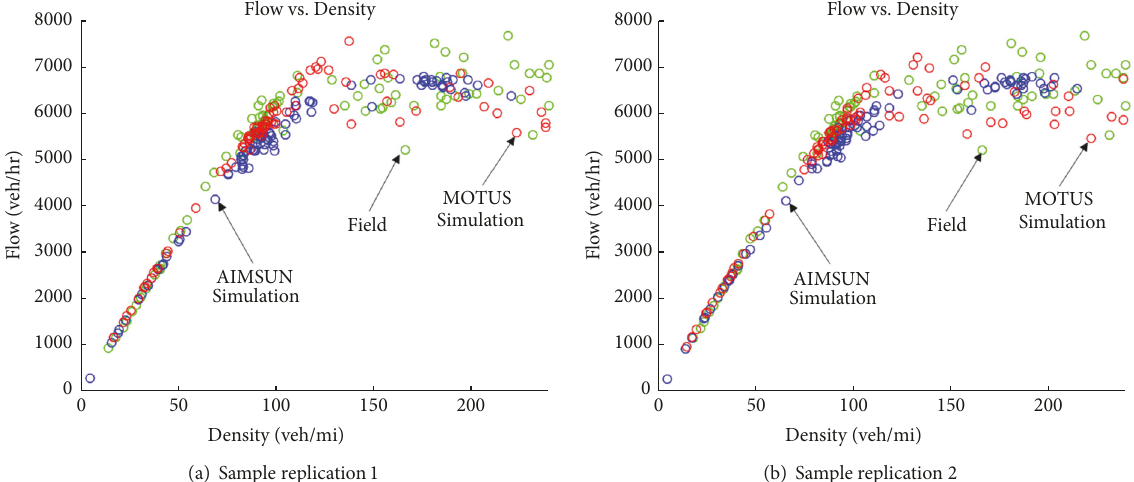
Figure 6: Comparison of field observed and AIMSUN and MOTUS simulated flow versus density relationship at Florin Rd. bottleneck (mile